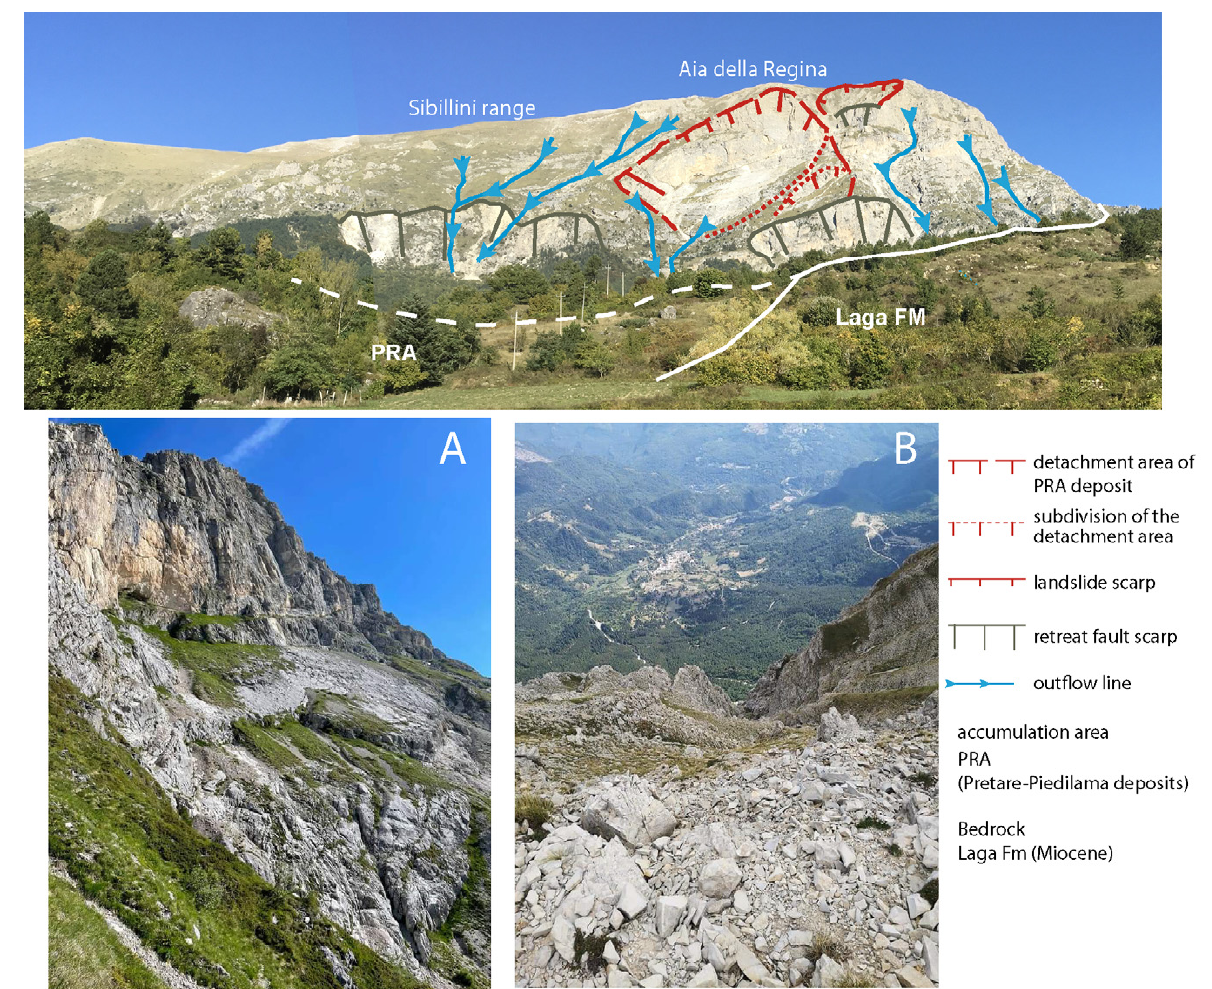
Figure 9. Panoramic view of the Monte Vettore fault scarp, of the detachment area of the rock avalanche, and of the contact between PRA deposit (Pretare-Piedilama roch avalanche) and the Laga Fm. ( A ) detail of the detachment area at the Aia della Regina, ( B ) erosive outflow channel flowing in the lower part of the detachment area.